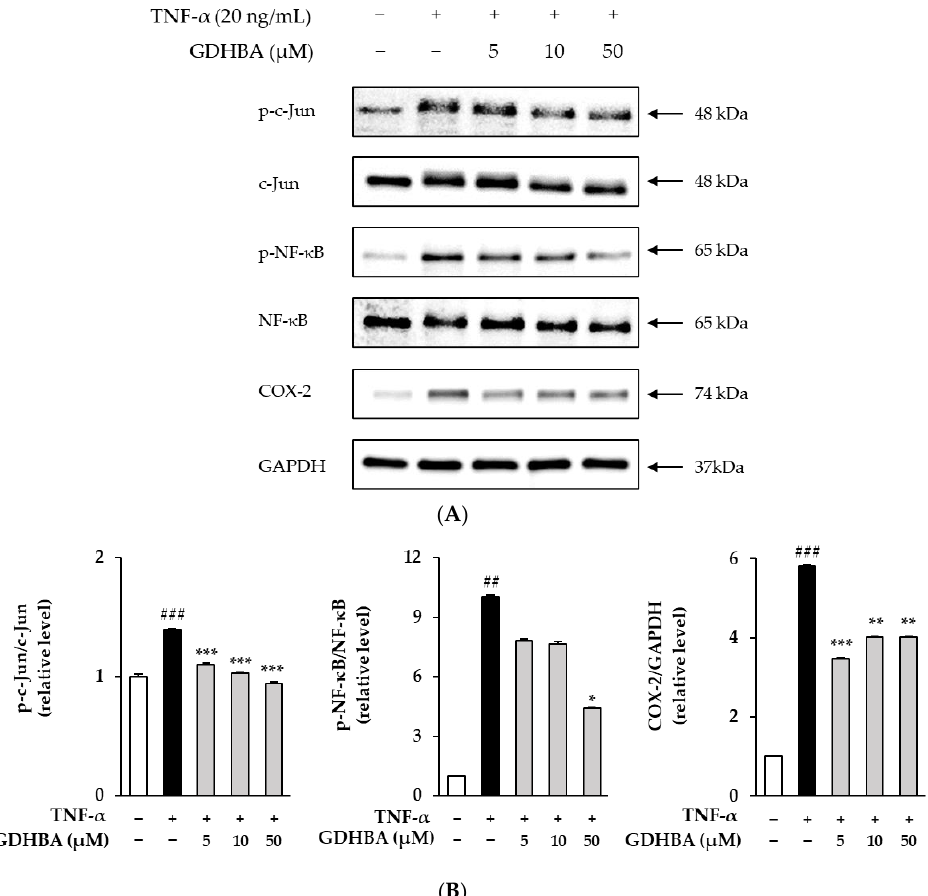
Figure 5. Effect of GDHBA on c-Jun, NF- κB , and COX-2 levels in TNF- α -treated HDFs. HDFs were pretreated with 5, 10, and 50 μM GDHBA ( A , B ) for 1 h and then incubated for 15 min and 6 h with TNF- α (20 ng/mL). Western blotting was performed to measure the expression of p-c-Jun, c-Jun, p-NF- κ B NF- κ B, COX-2, and GAPDH. Each bar represents mean ± SEM. ## p < 0.01 and ### p < 0.001 versus normal control. * p < 0.05, ** p < 0.01, and *** p < 0.001 versus stimulus alone.